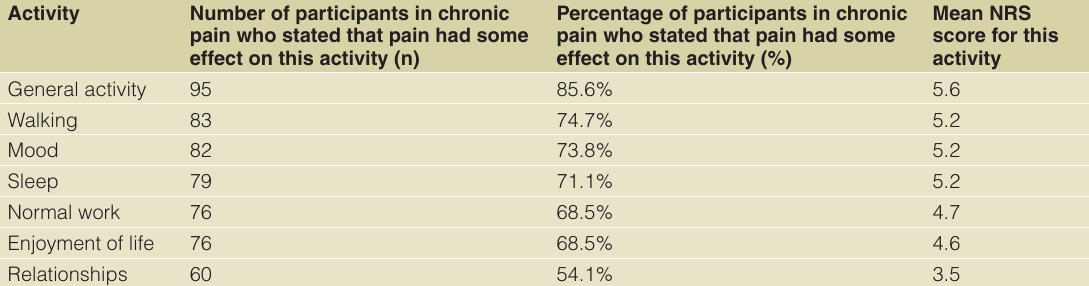
Table 2. The activities of participants’ daily living affected by chronic pain, and the extent of perceived interference.